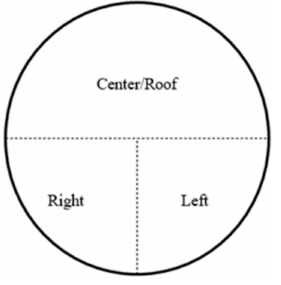
Figure 4. Tunnel zones during characterizations.